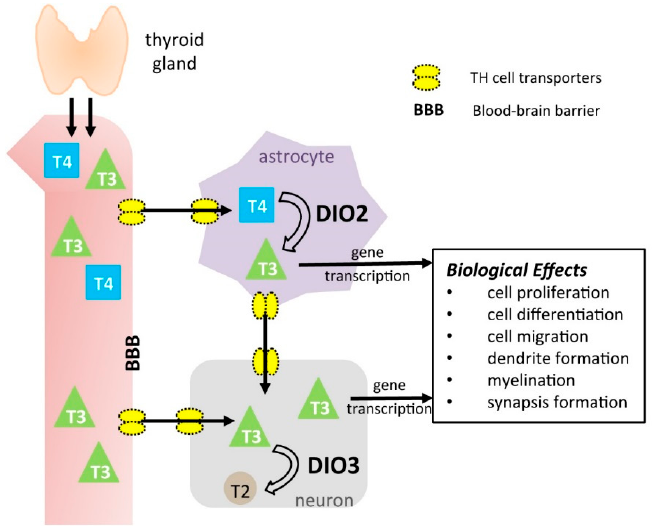
Figure 1. Mechanisms of thyroid hormone action in the brain and its biological effects. DIO2 and DIO3, type 2, and type 3 deiodinase, respectively. T3, triiodothyroinine; T2, diiodothyronine; T4,